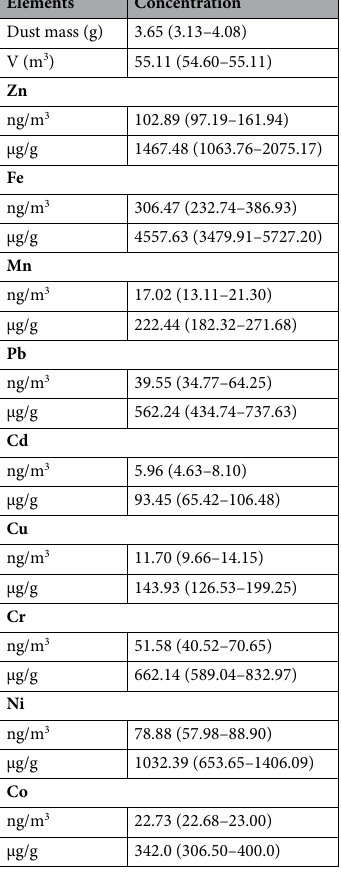
Table S1. The fold changes < 1 were converted and presented as negative values. Protein concentration measurements. The levels of the IL-1β, IL-6, and IL-8 in cell culture superna- tants were measured using ELISA kits (Thermo Fisher, MA, USA) according to the manufacturer’s procedure. The sensitivity of kits was 2 pg/ml. Measurements of transepithelial electrical resistance (TEER). facturer’s protocol. Two hundred microliters of PBS were added to the upper chamber in the cell culture system. The ohmic resistance of a blank (culture insert without cells) was evaluated for each experiment’s measurement and was subtracted from the total resistance of the sample. Flow cytometry analysis. For epithelial FACS measurements, cells from the upper chamber (ALI cul- tured epithelial cells alone or co-cultured with moMφs or/and moDCs) were evaluated. The cells were stained with antibodies against CD326, CD45, EGFR, mucin 1 (MUC1), TGF-β1, β-tubulin (BD Biosciences, San Jose, CA, USA), IL-33 receptor (ST2) (Biotechne, R&D Systems, MN, USA) and analyzed using the FACSCelesta instrument (BD Biosciences, San Jose, CA, USA). A detailed protocol of FACS analysis is described in the sup- plementary file, the characterization of fluorochrome-conjugated antibodies used for epithelial cell staining is shown in Table S2. The epithelial cell subpopulations were defined as follows: